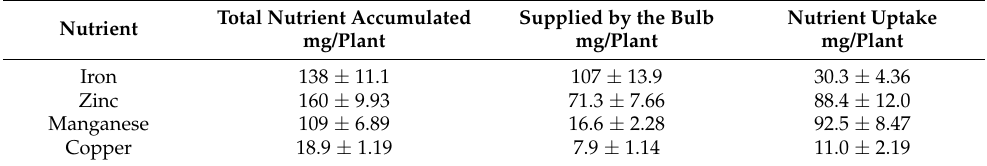
Table 2. Total micronutrients accumulated by lilium plants (mean ± standard error) at the end of the growing season and the amount provided by the bulb or absorbed from the growing